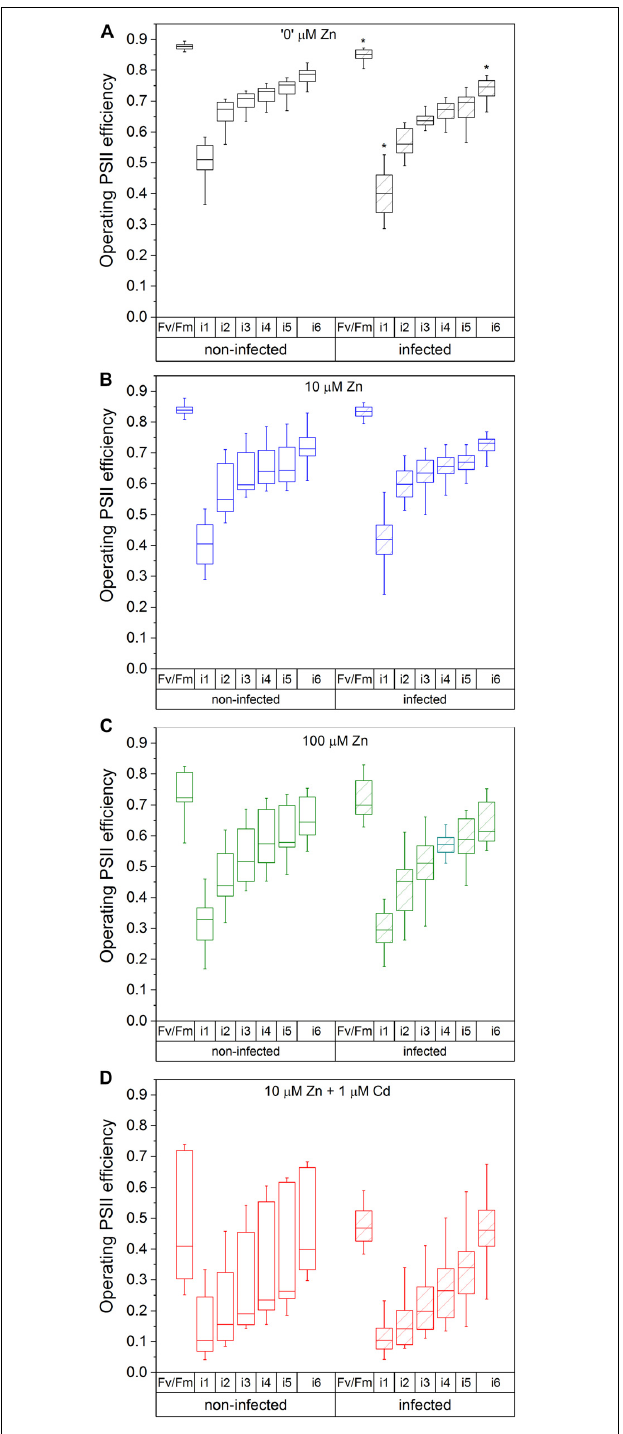
FIGURE 2 | Operating PSII efficiency in the irradiation phase, with the dark-adapted maximal quantum yield of PSIRC (F v /F m ) as a reference. Zn0 (A) , Zn10 (B) , and Zn100 (C) refer to Zn concentrations used in the treatments (‘0’ = 0.01, 10 and 100 µ M Zn), Cd1 (D) refers to a 1 µ M Cd + 10 µ M Zn treatment. The line presents the median value ( n = 6–8), the box shows the values between the 0.25–0.75 percentiles, and the